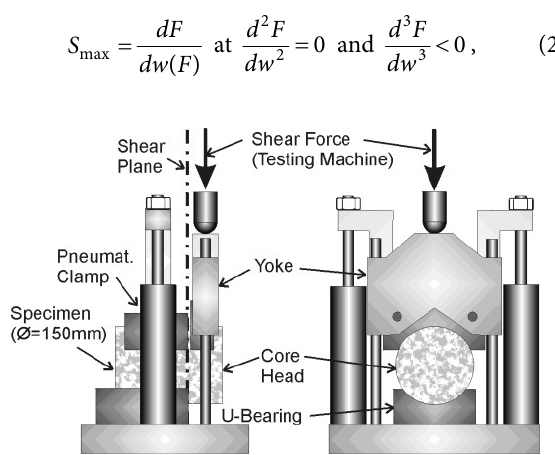
Fig. 1. LPDS test device, schematic drawing (Raab, Partl 2008)